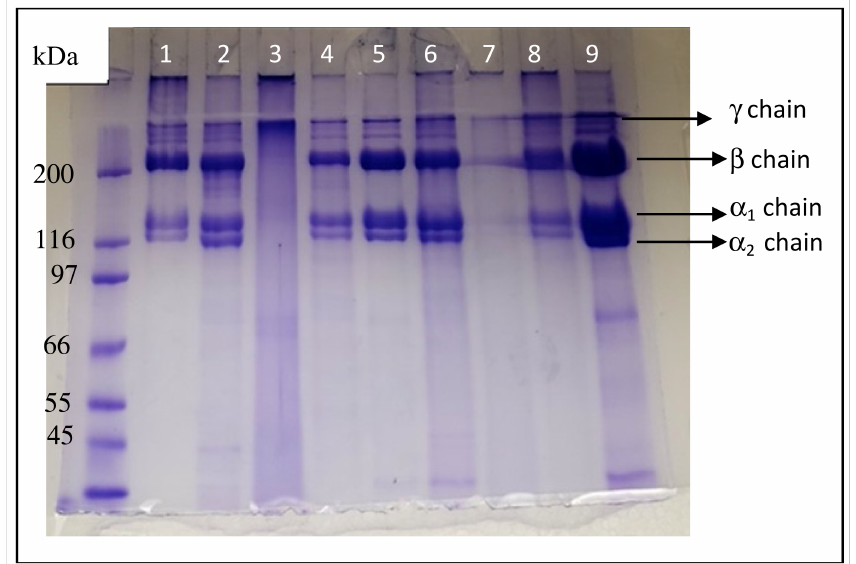
Figure 1. SDS-PAGE analysis of acid-solubilized collagen (ASC) and pepsin-solubilized collagen (PSC) from catfish (1) PSC skin, (2) PSC fin, (3) PSC muscle, (4) PSC head, (5) ASC head, (6) ASC bone, (7) ASC muscle (8) ASC fin, and (9) ASC